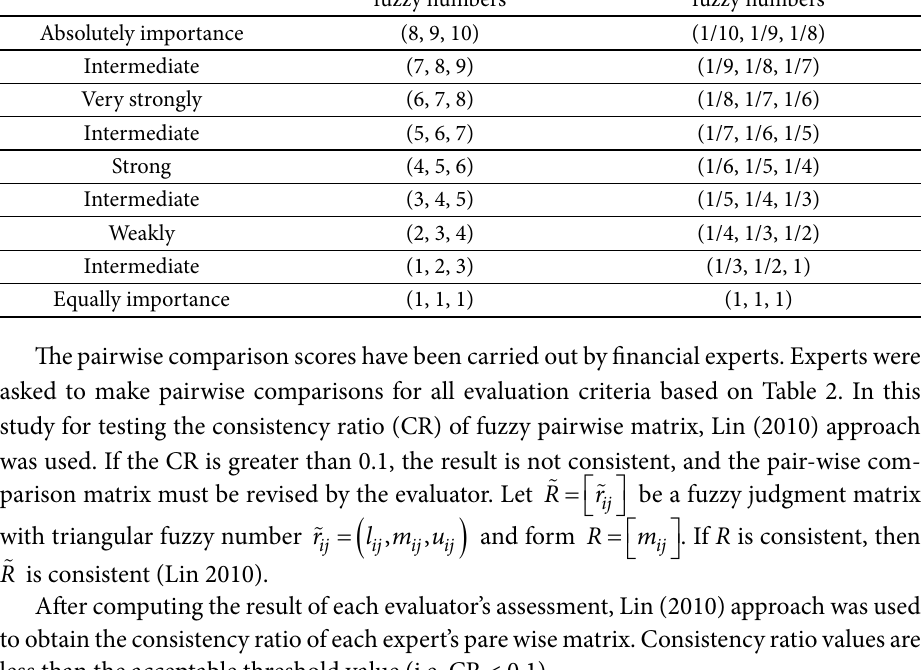
Table 3. Membership function of linguistic scale (Chou, Cheng 2012) Linguistic scale